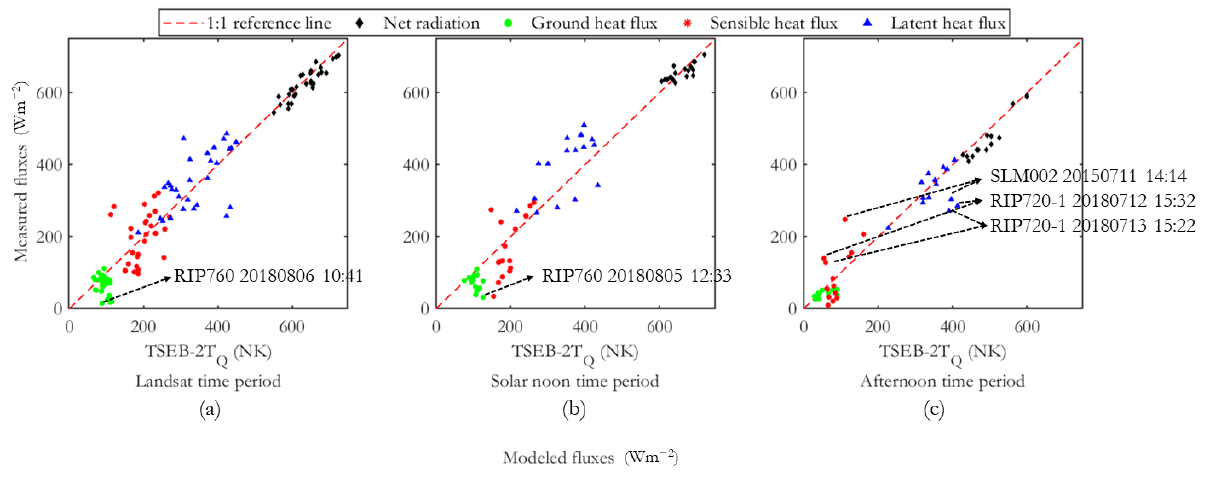
Figure 6. Scatter plots illustrating the performance of the TSEB-2T Q model coupled with the Norman and Kustas (NK) resistance model at different time periods.